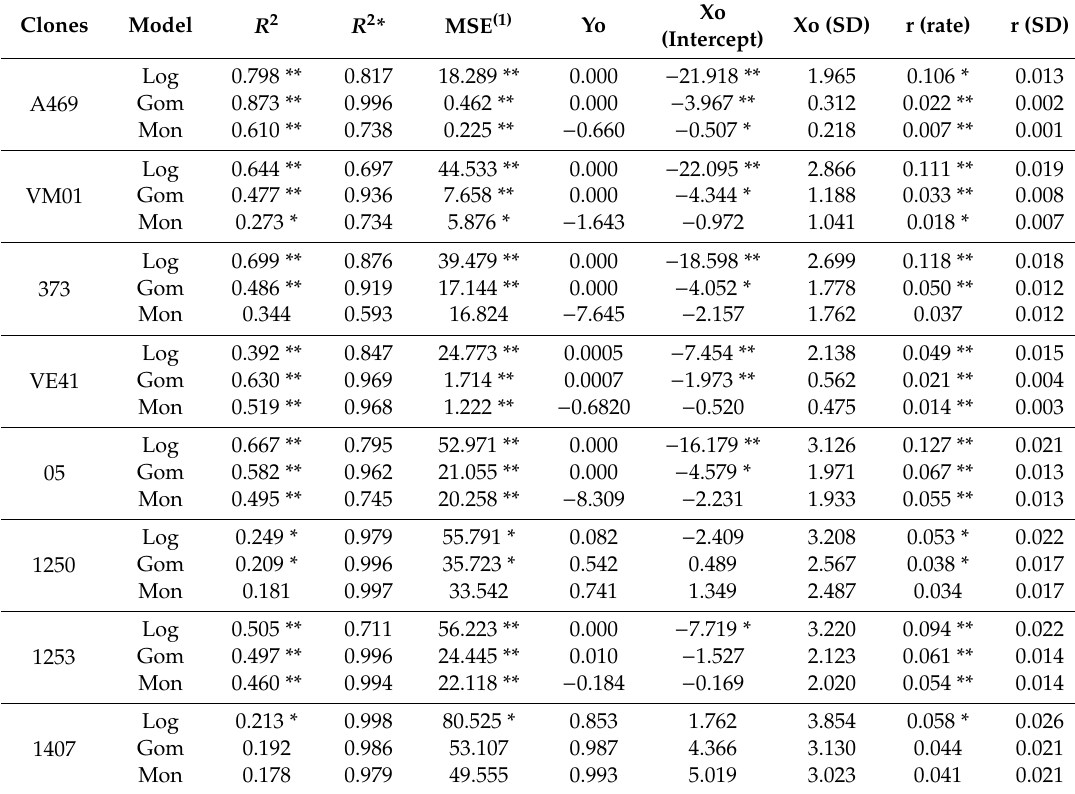
Table 1. Parameters used in the regression analysis of linear models to compare model fits (Logistic, Gompertz, and Monomolecular) for bacterial leaf blight in eight eucalyptus